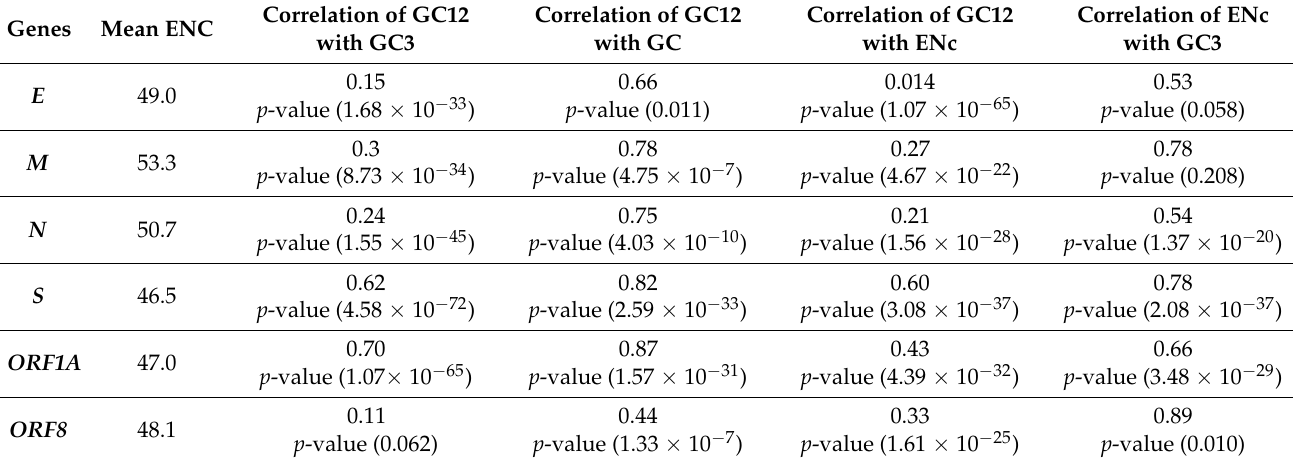
Table 2. Mean ENc and Correlation between various parameters analyzed for a different set of genes in the Coronaviridae family. Genes Mean